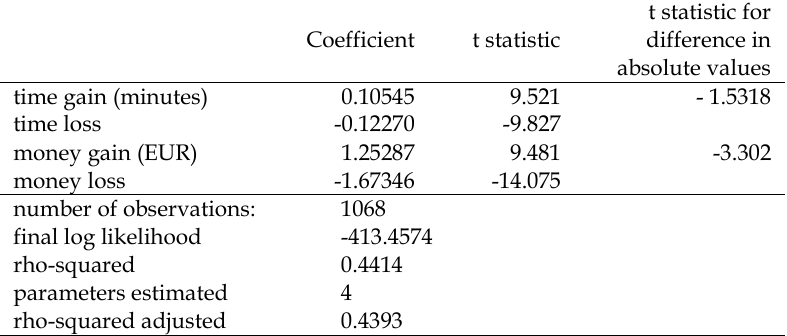
Table 1. Estimation results for the route choice model